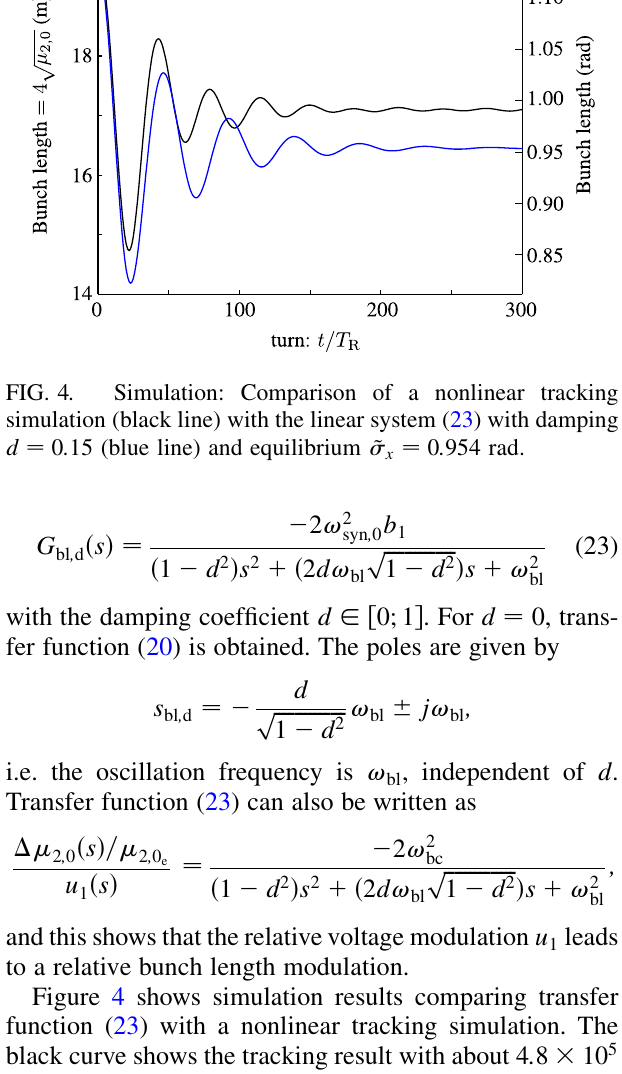
TABLE II. Bunch sizes: simulation (S) in Sec. III C and ex- periment (A, B, C). Before voltage step After voltage step